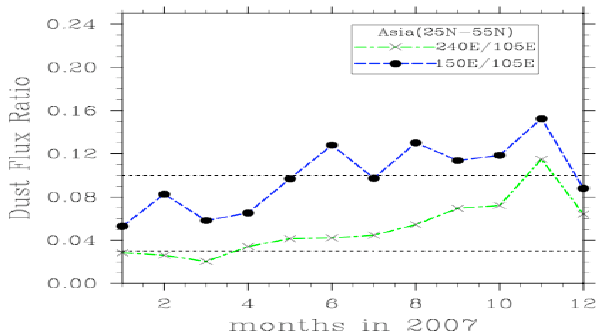
Fig. 8. Modeled ratios of monthly dust flux between 25 ◦ N to 55 ◦ N for Asian dust in 2007. The horizontal dashed lines are the 0.1 and 0.03 lines.